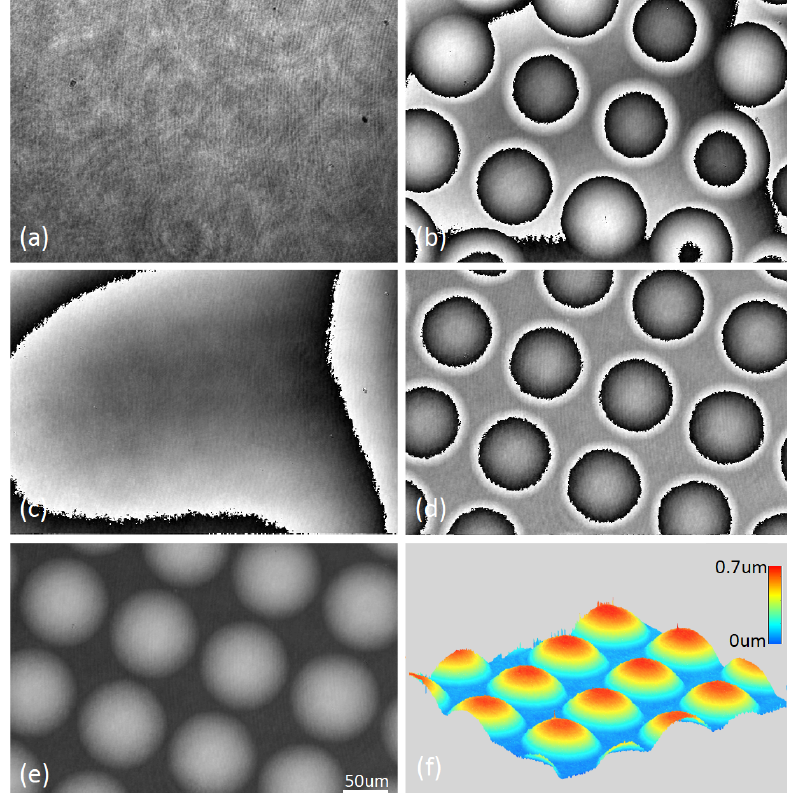
Figure 3. Results for a micro-lens array using a 20 × /0.46 microscope objective providing a spatial and depth resolution of approximately 1.38 µ m and 1 nm, respectively: ( a , b ) are the reconstructed amplitude and phase; ( c ) the phase image recorded from a reference hologram and ( d ) the phase image of the object following aberration compensation using this reference hologram; ( e ) the unwrapped phase and ( f ) a 3D rendering of the thickness